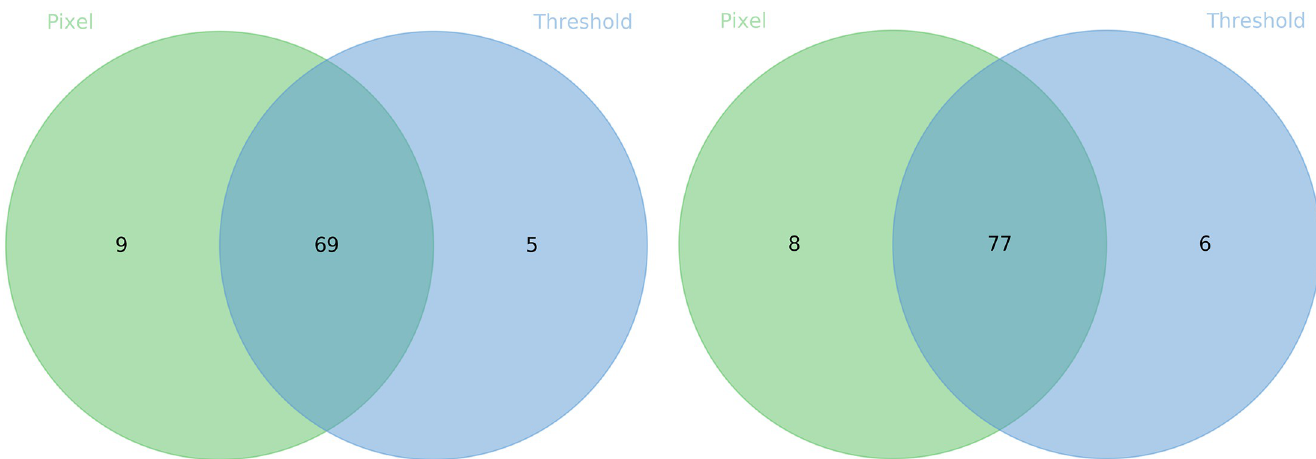
Fig 6. Distribution of adversarial samples. Distribution of adversarial samples found on DenseNet (left) and ResNet (right) using th = 10 with both few-pixel ( L 0 ) and threshold ( L 1 )